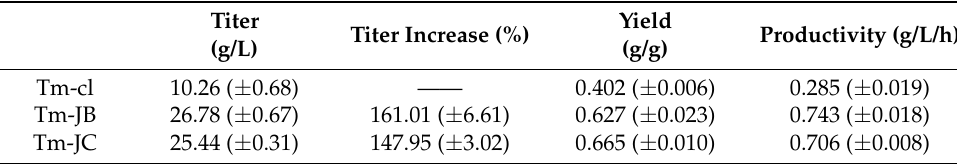
Table 1. Titers, titer increase, yield, and productivity of L-threonine under dynamically regulated RhtB and